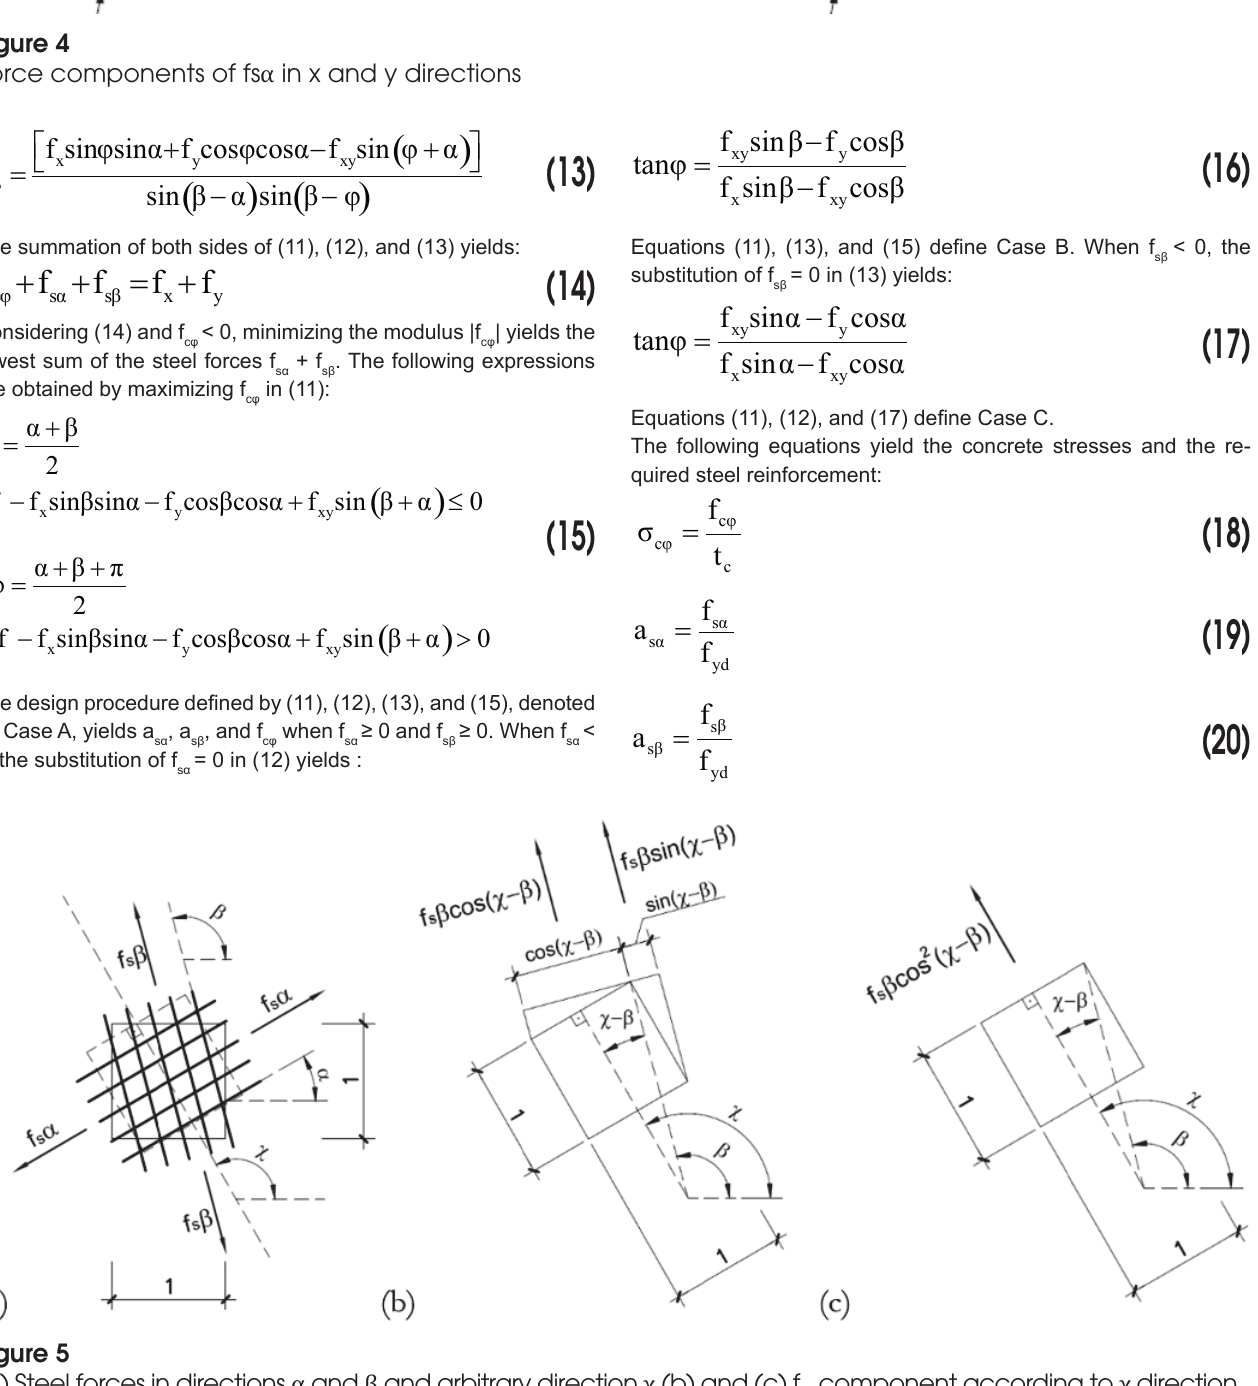
and and arbitrary direction α β